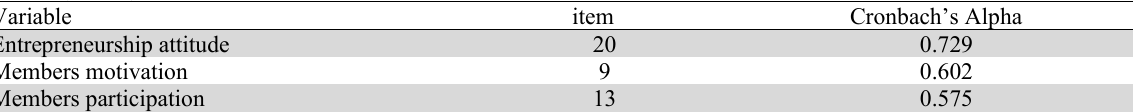
Reliability Analysis Result Variable